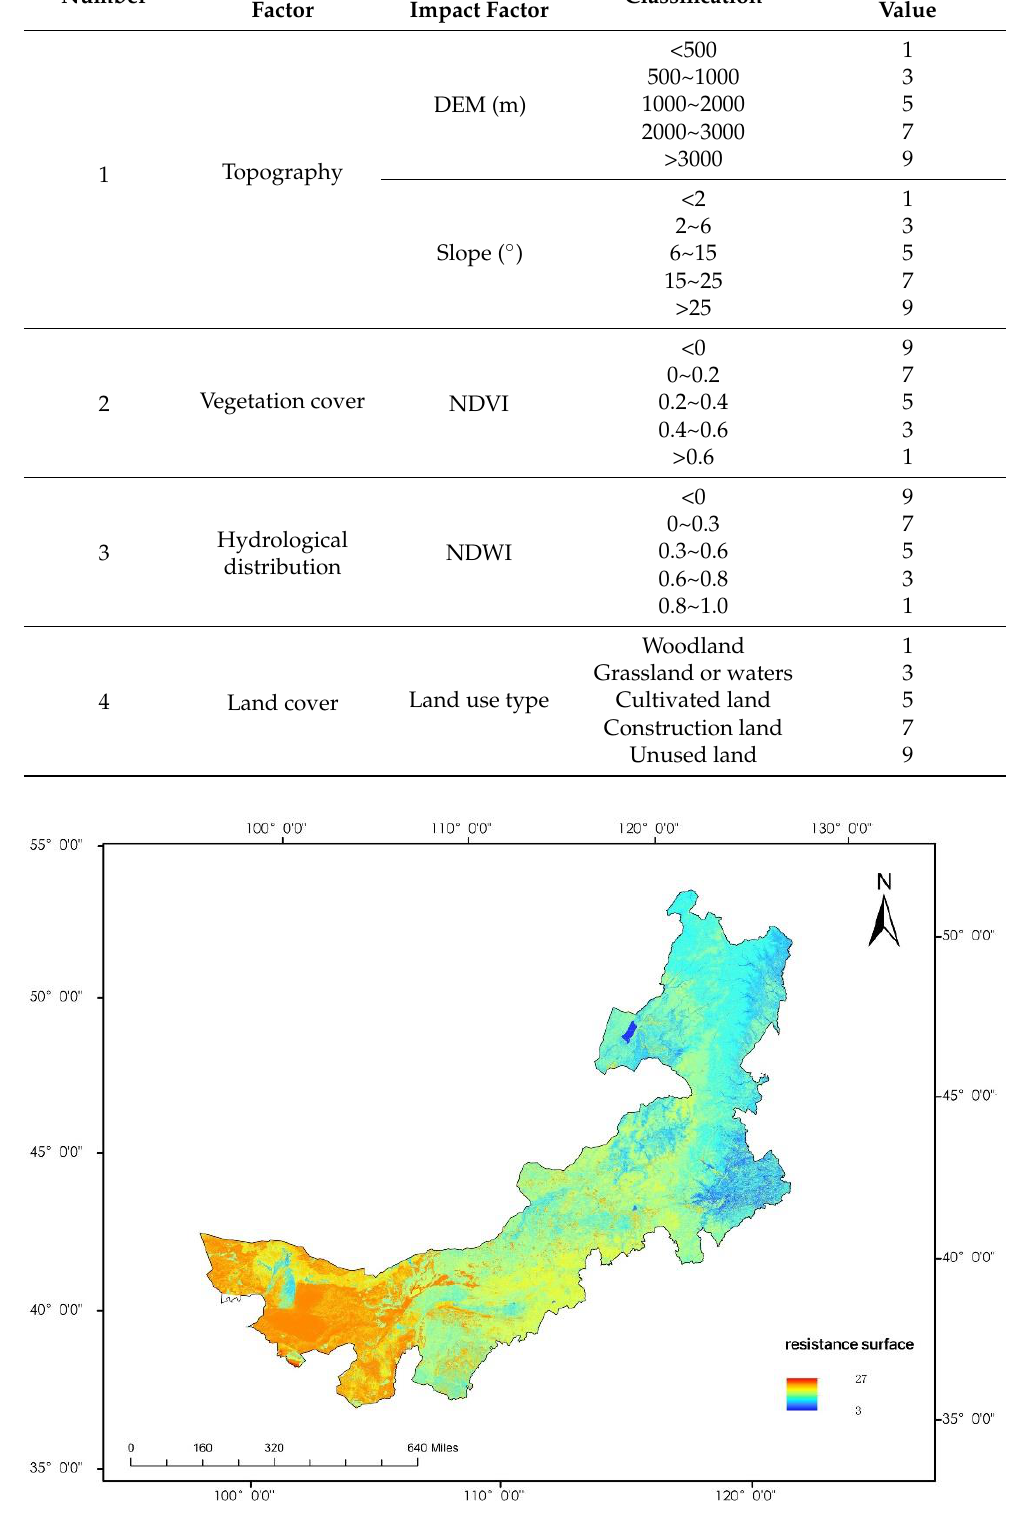
Figure 4. Cumulative resistance surface in the study area.